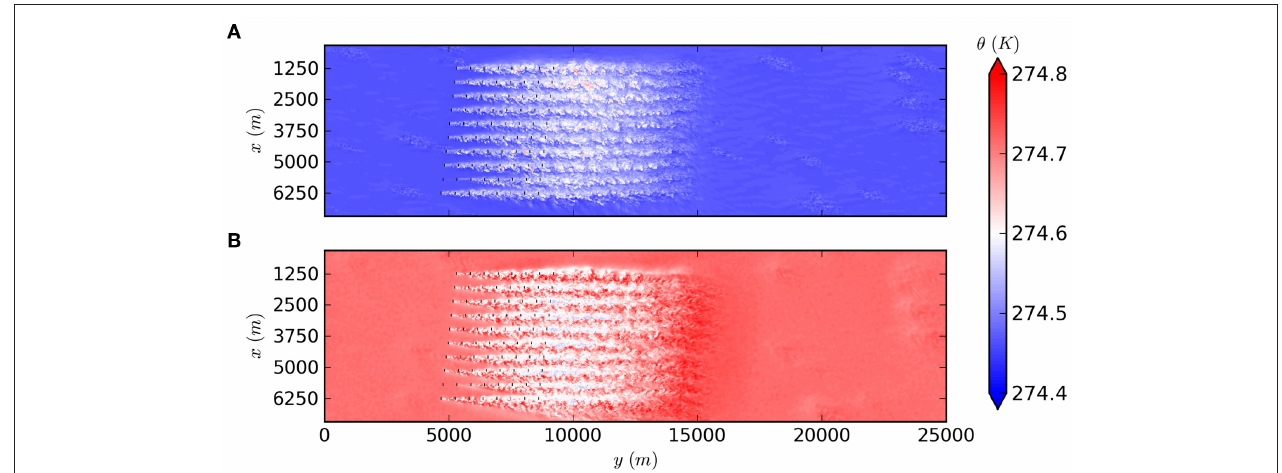
FIGURE 10 | Horizontal cross-section at 30 m (A) and 110 m (B) above the sea of the potential temperature θ . The red plain lines (–) indicate the locations of wind turbines.